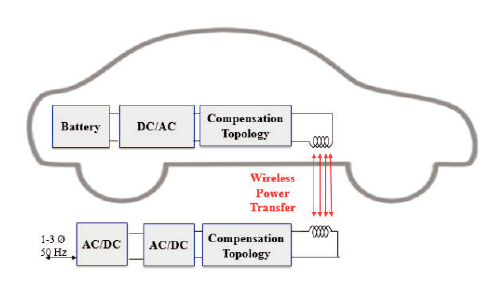
Fig. 2. Structure of a bidirectional wireless